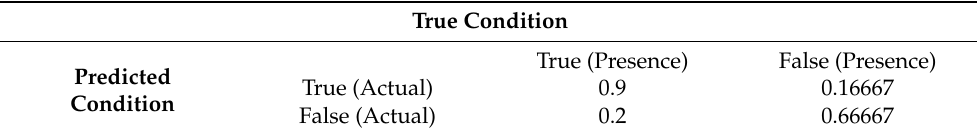
Table 3. Confusion matrix for detections done in the inner cells of video frame.